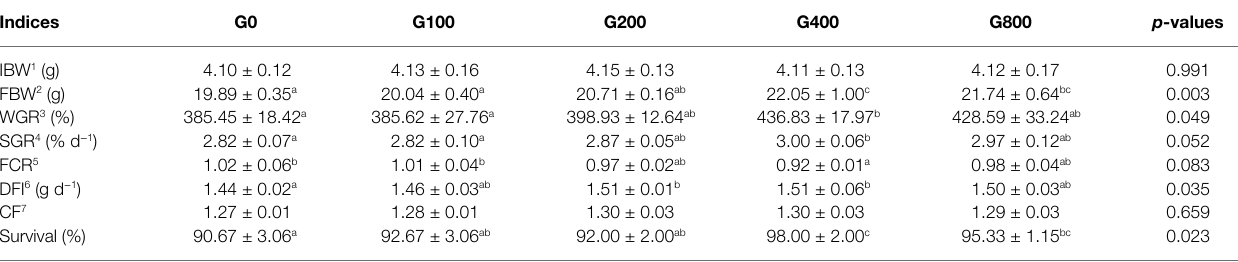
TABLE 3 | Growth performances of O. mykiss fed the experimental diets (mean ± SD, n = 3). Indices